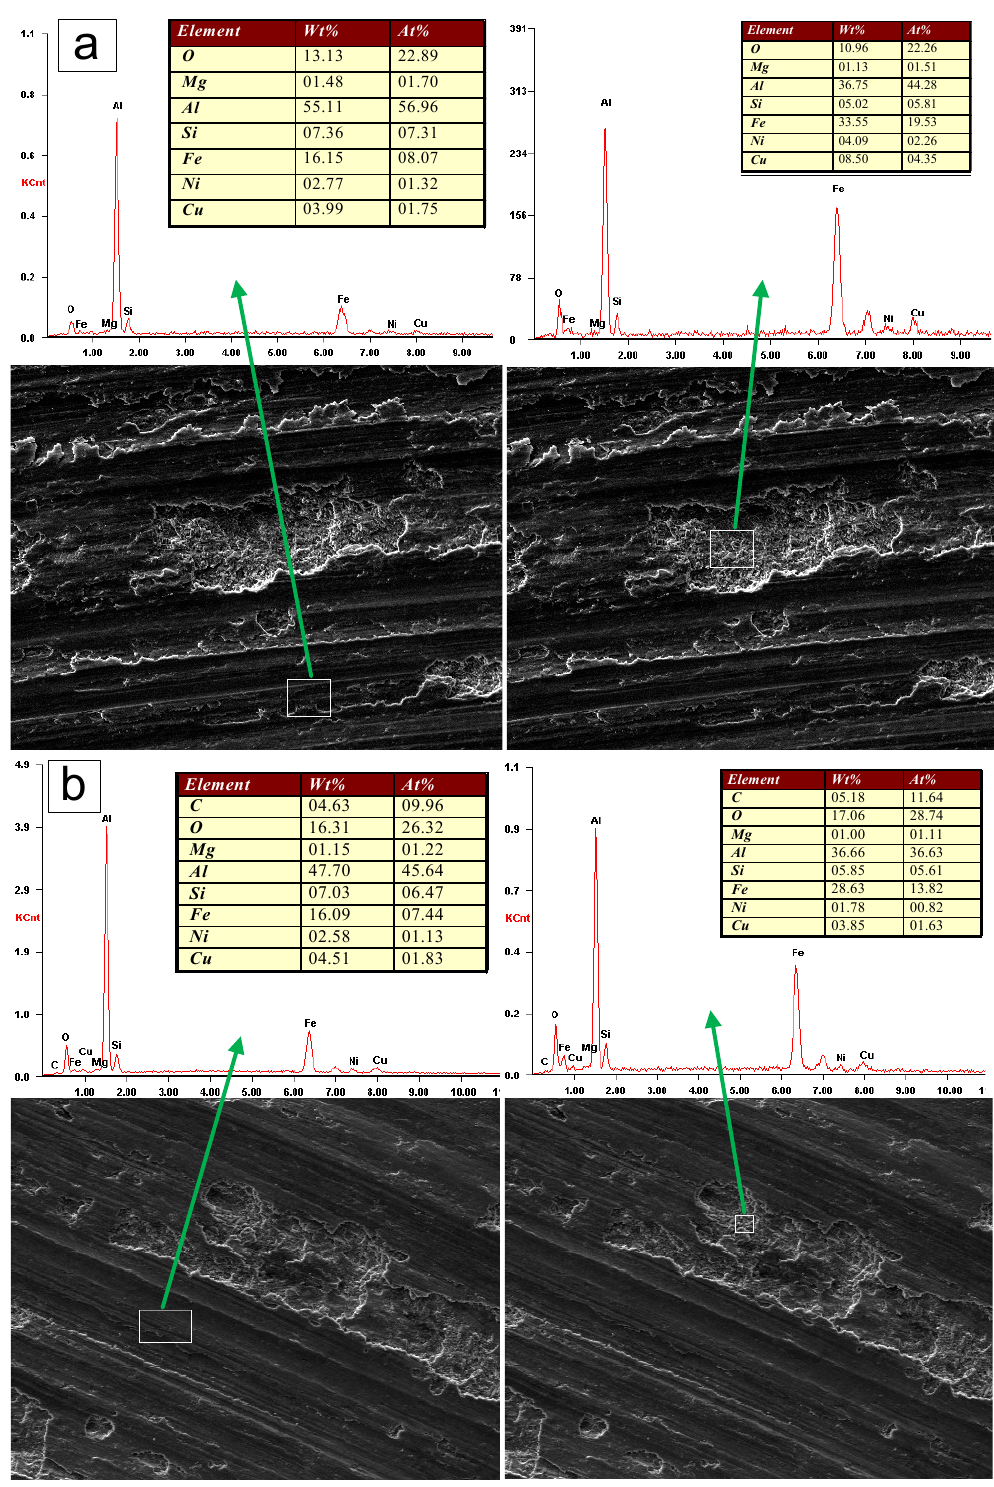
Figure 7. Energy dispersive spectroscopy (EDS) analysis results for the ( a ) Al–12Si–CuNiMg matrix alloy and ( b ) composite under identical wear conditions at 1.0 m/s and 5.0 N,